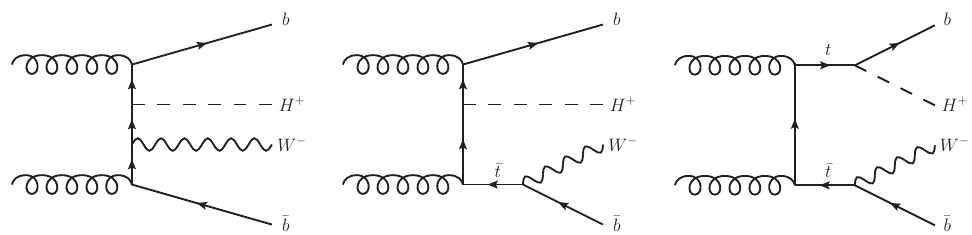
Figure 4: Examples of leading-order Feynman diagrams contributing to the produc- tion of charged Higgs bosons in pp collisions: (left) non-resonant top-quark pro- duction, (center) single-resonant top-quark production that dominates at large H + masses, (right) double-resonant top-quark production that dominates at low H + masses. The interference between these three main diagrams becomes most rele- vant in the intermediate-mass